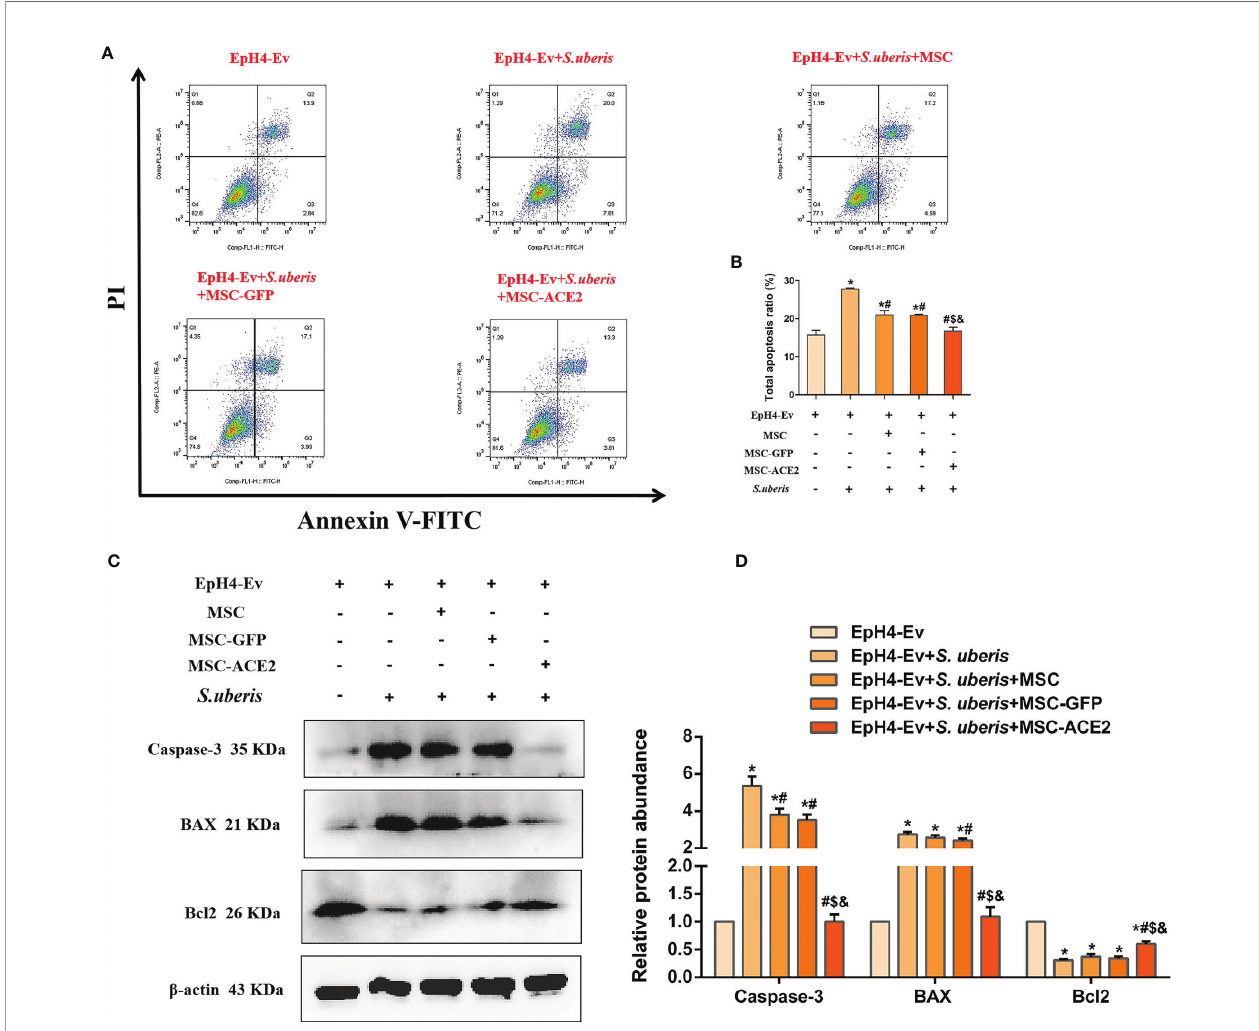
FIGURE 4 | MSC-ACE2 inhibited EpH4-Ev cells apoptosis induced by S. uberis . (A) Apoptosis kit to detect apoptosis rate. (B) Total apoptosis ratio of EpH4-Ev cells. (C) Detection of relative protein expression levels of Caspase-3, Bax, and Bcl-2 by Western blot. (D) Statistics of the Caspase-3, Bax, and Bcl-2 Western blot results. Experiments were repeated three times and data were presented as the mean ± SEM (n = 3). * P < 0.05 vs. EpH4-Ev; # P < 0.05 vs. S. uberis ; $ P < 0.05 vs. MSC; & P < 0.05 vs.